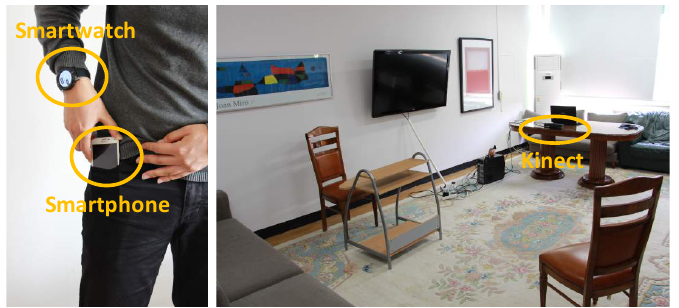
Figure 5. Sensor devices used for the collection of the multimodal context mining dataset. The smartwatch was generally placed by users on the right wrist, while the smartphone was kept in different locations based on the user’s choice. The Kinect video device was only used for monitoring in the home